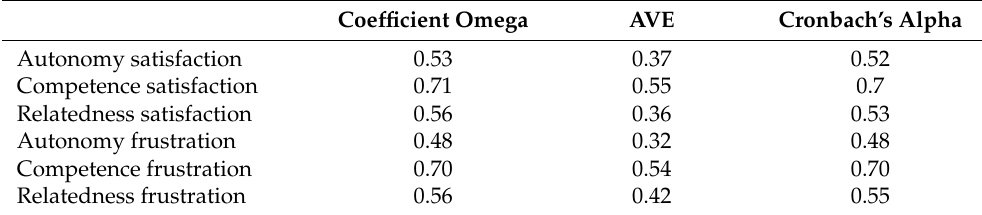
Table A3. Coefficient omega and Average Variance Extracted (AVE) in the 6-factor model, and Cronbach’s alpha ( N = 344).